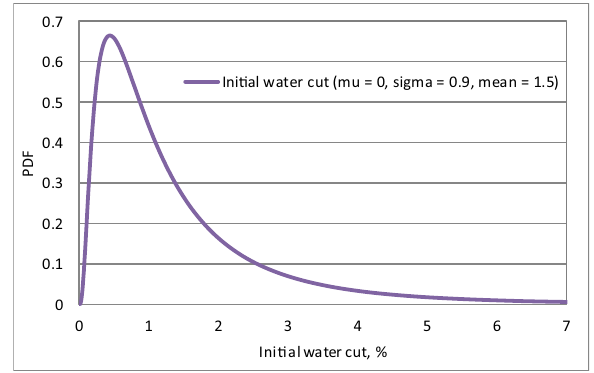
Fig. 15 Probability distribution function (PDF) for the initial water